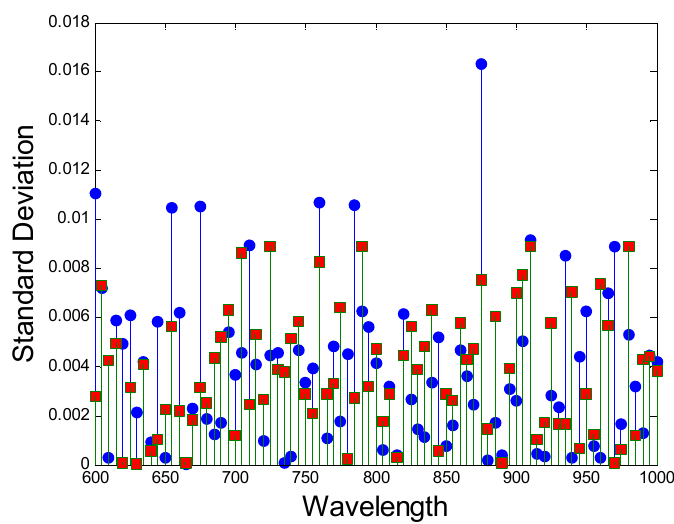
Figue 6. The standard deviation in each